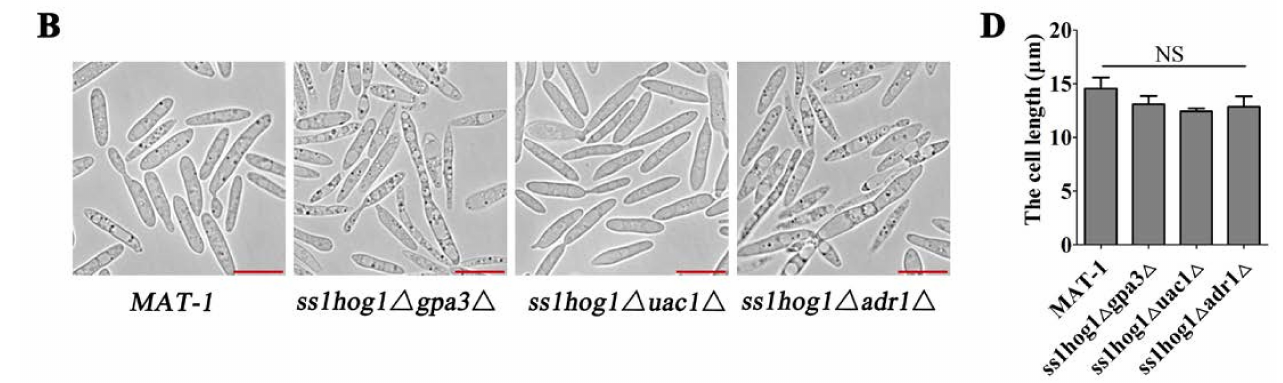
Figure 4. Morphology of SsHog1 and cAMP/PKA signaling pathways’ double-deletion mutants. ( A ) The colony morphology of MAT-1 , ss1hog1 ∆ gpa3 ∆ , ss1hog1 ∆ uac1 ∆ , and ss1hog1 ∆ adr1 ∆ strains. MAT-1 , ss1hog1 ∆ gpa3 ∆ , ss1hog1 ∆ uac1 ∆ , and ss1hog1 ∆ adr1 ∆ haploid sporidia were spotted